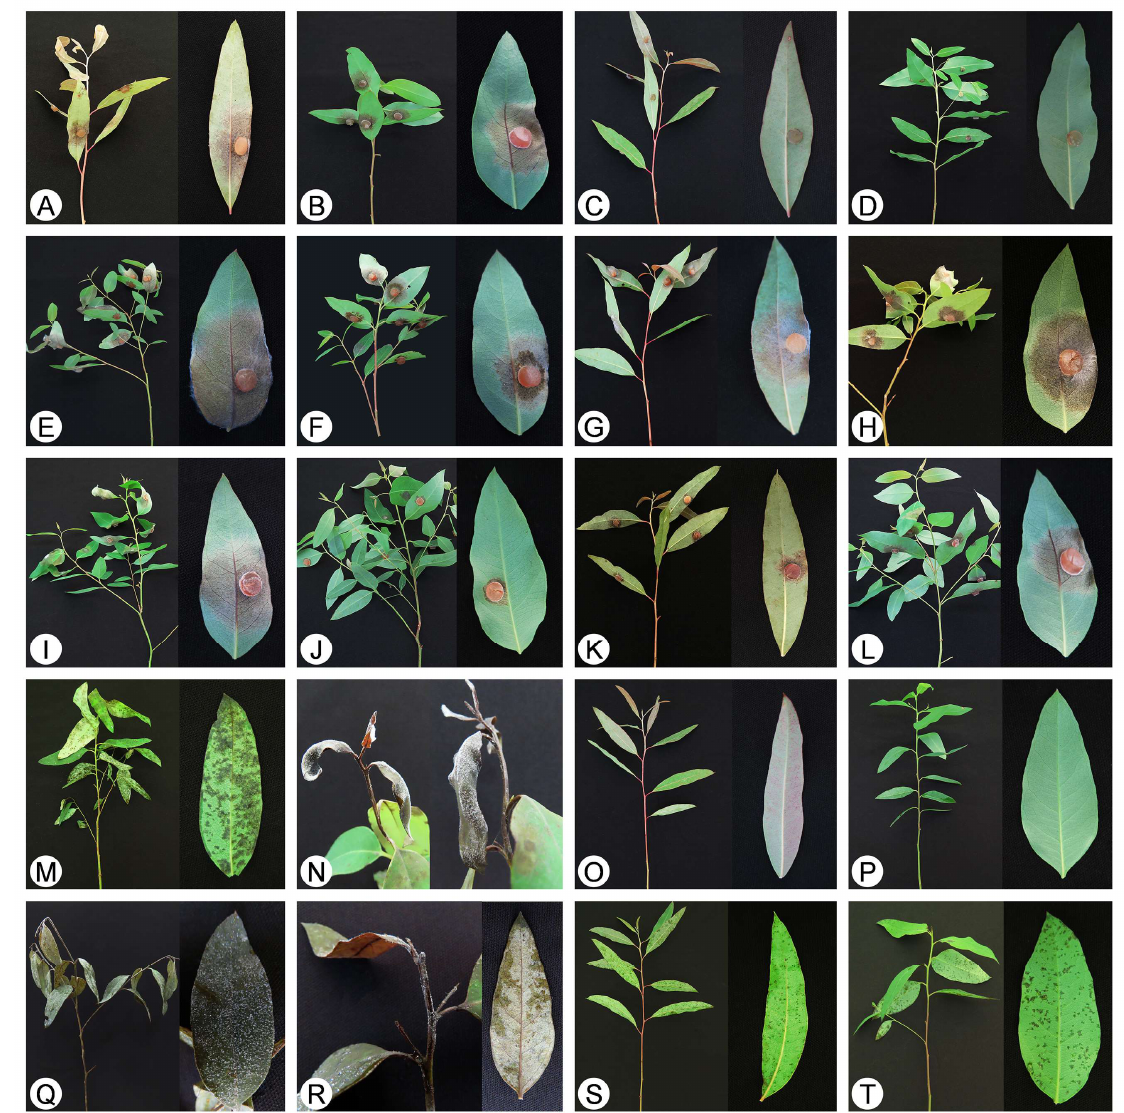
Figure 6. Symptoms on seedlings of E. urophylla × E. tereticornis hybrid genotype CEPT1876 and E. urophylla × E. grandis hybrid genotype CEPT1877 inoculated by Calonectria mycelia plugs/MEA plugs ( A – L ) and conidia suspensions/sterile water ( M – T ) of five Calonectria isolates. ( A ): CEPT1876 inoculated by isolate CSF16130 ( C. aconidialis ); ( B ): CEPT1877 inoculated by isolate CSF16016 ( C. pseudoreteaudii ); ( C,D ): No disease symptoms were observed on leaves of CEPT1876 ( C ) and CEPT1877 ( D ) inoculated by sterile MEA plugs (negative controls); ( E ): Isolate CSF16130 ( C. aconidialis ) produced the longest lesions on CEPT1877; ( F ): Long lesions produced by isolate CSF16145 ( C. hongkongensis ) on CEPT1877; ( G,H ): Isolate CSF16230 ( C. hongkongensis ) produced long lesions on CEPT1876 ( G ) and CEPT1877 ( H ); ( I,J ): Isolate CSF15985 ( C. pseudoreteaudii ) produced significantly larger lesions on CEPT1877 than that of isolate CSF16056 ( C. pseudoreteaudii ); ( K,L ): The inoculation results of isolate CSF16016 ( C. pseudoreteaudii ) indicated that CEPT1876 was significantly more tolerant than CEPT1877; ( M ): Lesions on leaves of CEPT1877 inoculated by isolate CSF16105 ( C. reteaudii ); ( N ): Genotype CEPT1877 rotted after inoculations by isolate CSF16130 ( C. aconidialis ), abundant white mass of conidiophores were observed; ( O,P ): No disease symptoms on CEPT1876 ( O ) and CEPT1877 ( P ) inoculated by sterile water (negative controls); ( Q,R ): All leaves of CEPT1877 blighted and the seedling died after infection by isolates CSF15985 ( Q ) ( C. pseudoreteaudii ) and CSF16185 ( R ) ( C. auriculiformis ); ( S,T ): Lesions on CEPT1876 ( S ) and CEPT1877 ( T ) inoculated by isolate CSF16130 ( C. aconidialis ). A – L , M – P , S and T are in the first experiment; Q and R are in the second experiment.